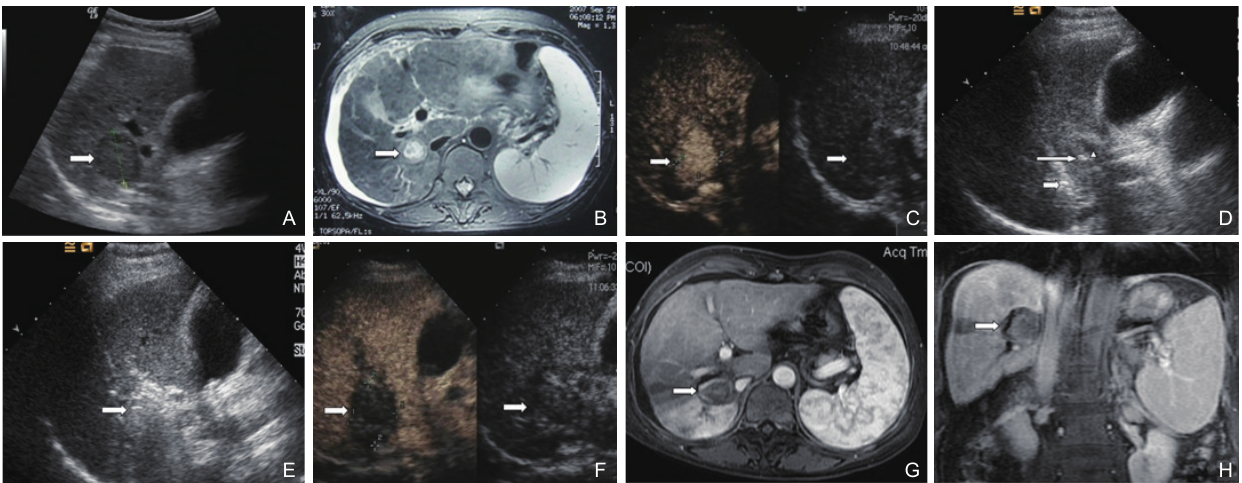
Figure 1 A 55-year-old woman with hepatitis B virus-related cirrhosis and HCC in the right lobe of the liver treated with RF ablation combined with PEI, and the tumor is adjacent to the hepatic hilum. (A) Gray-scale ultrasound shows the tumor (arrow) was hypoechoic and adjacent to the hepatic hilum;(B) CEUS shows the tumor hyper-enhanced (arrow) in the arterial phase;(C) MRI shows the tumor (arrow) located adjacent to the hepatic hilum;(D) The RF ablation electrode (short arrowhead) is placed into the tumor and the PEI needle (long arrowhead) is placed into the margin of the tumor proximal to the right hepatic duct ( △ );(E) During the therapy, the hyperechoic area of ablation (arrow) is monitored by real-time US;(F) One day after ablation, the ablated zone (arrowhead) is evaluated by CEUS and the tumor is completely destroyed;(G) Six months after ablation, MRI shows the tumor is completely destroyed (arrow);(H) Twelve months after therapy, MRI coronal plane scan shows the ablation zone